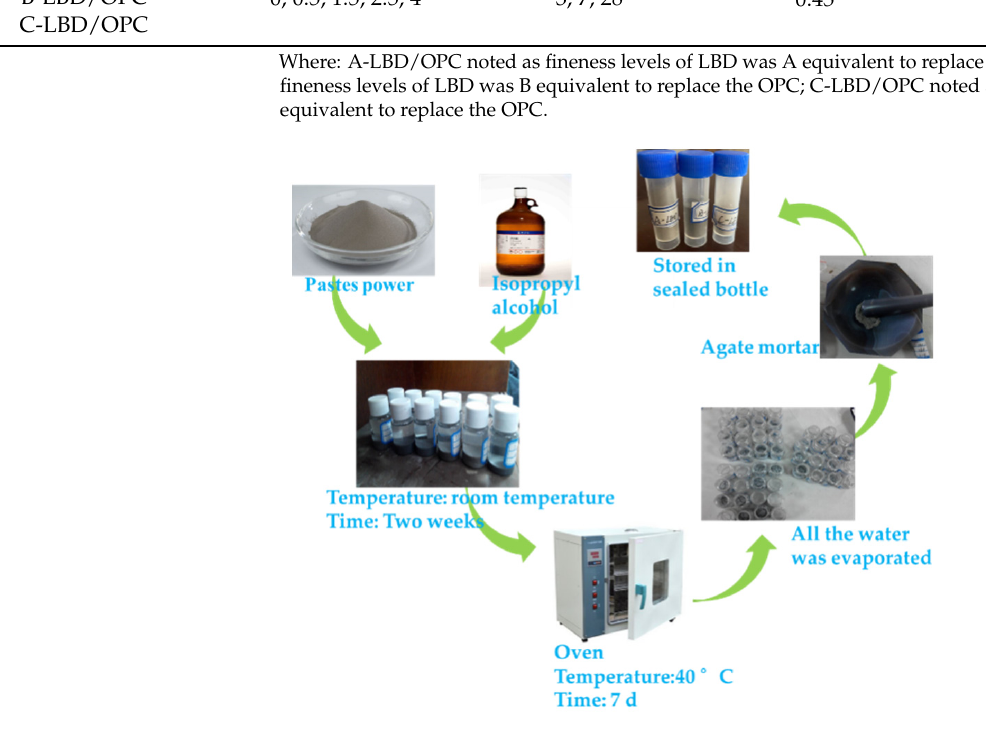
Table 2. Test samples of LBD/OPC pastes.